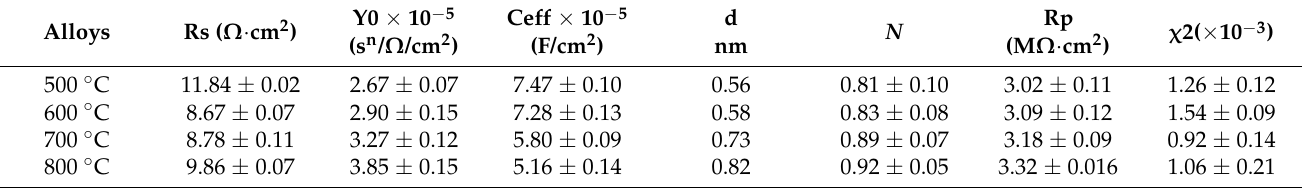
Table 3. Corrosion parameters of the annealed Ti-20Zr-15Mo alloy from EIS data in a 5 wt.% HCl